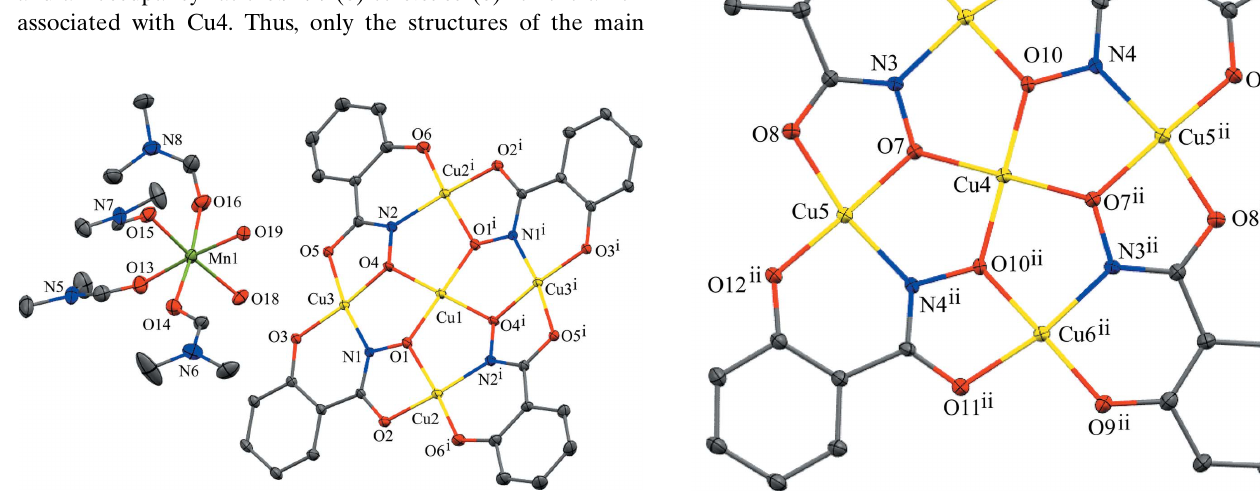
Figure 1 The single-crystal X-ray structure of the ionic pair cis - [Mn(H 2 O) 2 (DMF) 4 ]{Cu[12-MC Cu(II)N(shi) -4]} (cid:2) DMF associated with Cu1 and with displacement ellipsoids at the 50% probability level [symmetry code: (i) 2 (cid:3) x , (cid:3) y , 1 (cid:3) z ]. For clarity, only non-carbon atoms have been labeled, and the MC associated with Cu4, the lattice DMF molecule, H atoms, and disorder have been omitted. Color scheme: yellow – Cu II , green – Mn II , red – oxygen, blue – nitrogen, and gray – carbon. All figures were generated with the program Mercury (Macrae et al. ,